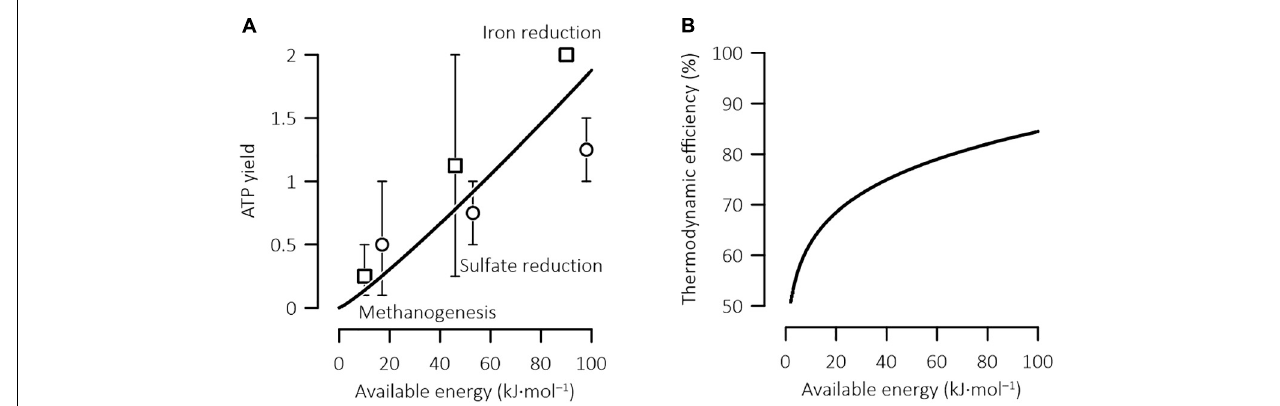
FIGURE 4 | Variations in the ATP yield (A) and thermodynamic efficiency (B) of microbial iron reduction, sulfate reduction, and methanogenesis with the energy available in the environment. The available energy is expressed in terms of one mole of acetate or four moles of H 2 ; solid lines are calculated according to Eqs 20, 21; data points are the ATP yields and available energies estimated previously ( (cid:3) ,